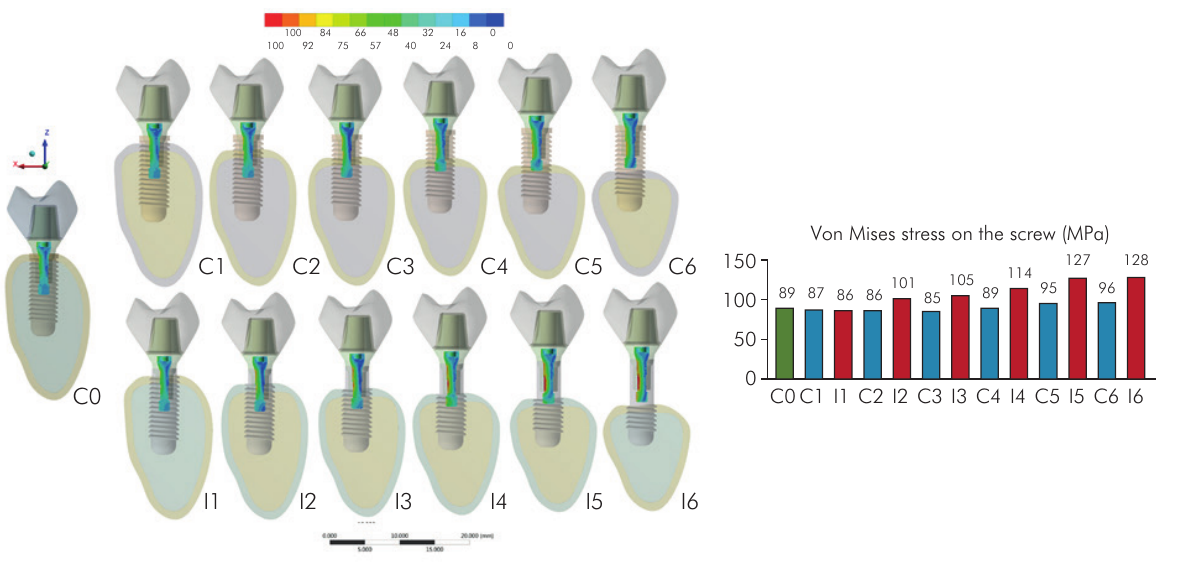
Figure 4. Stress distribution on the retention screw according to von Mises stress criteria for all groups.